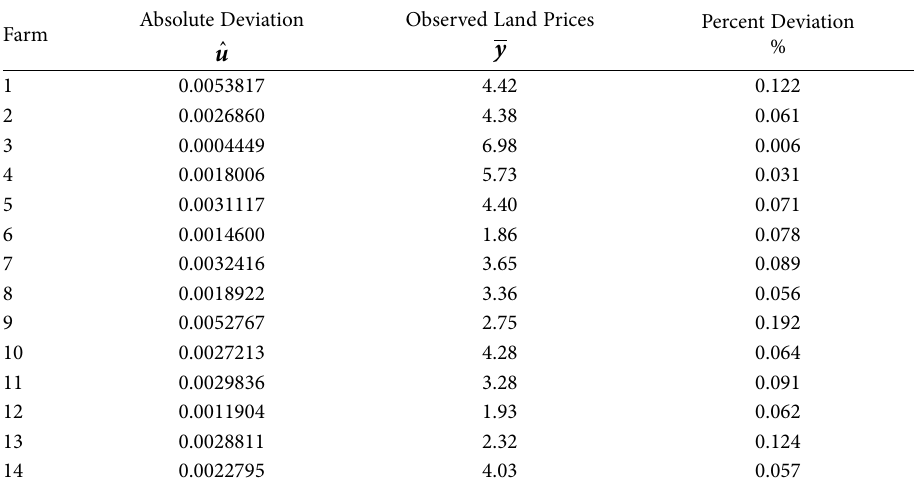
Table 2. Deviations of y ˆ from y : vector u ˆ.